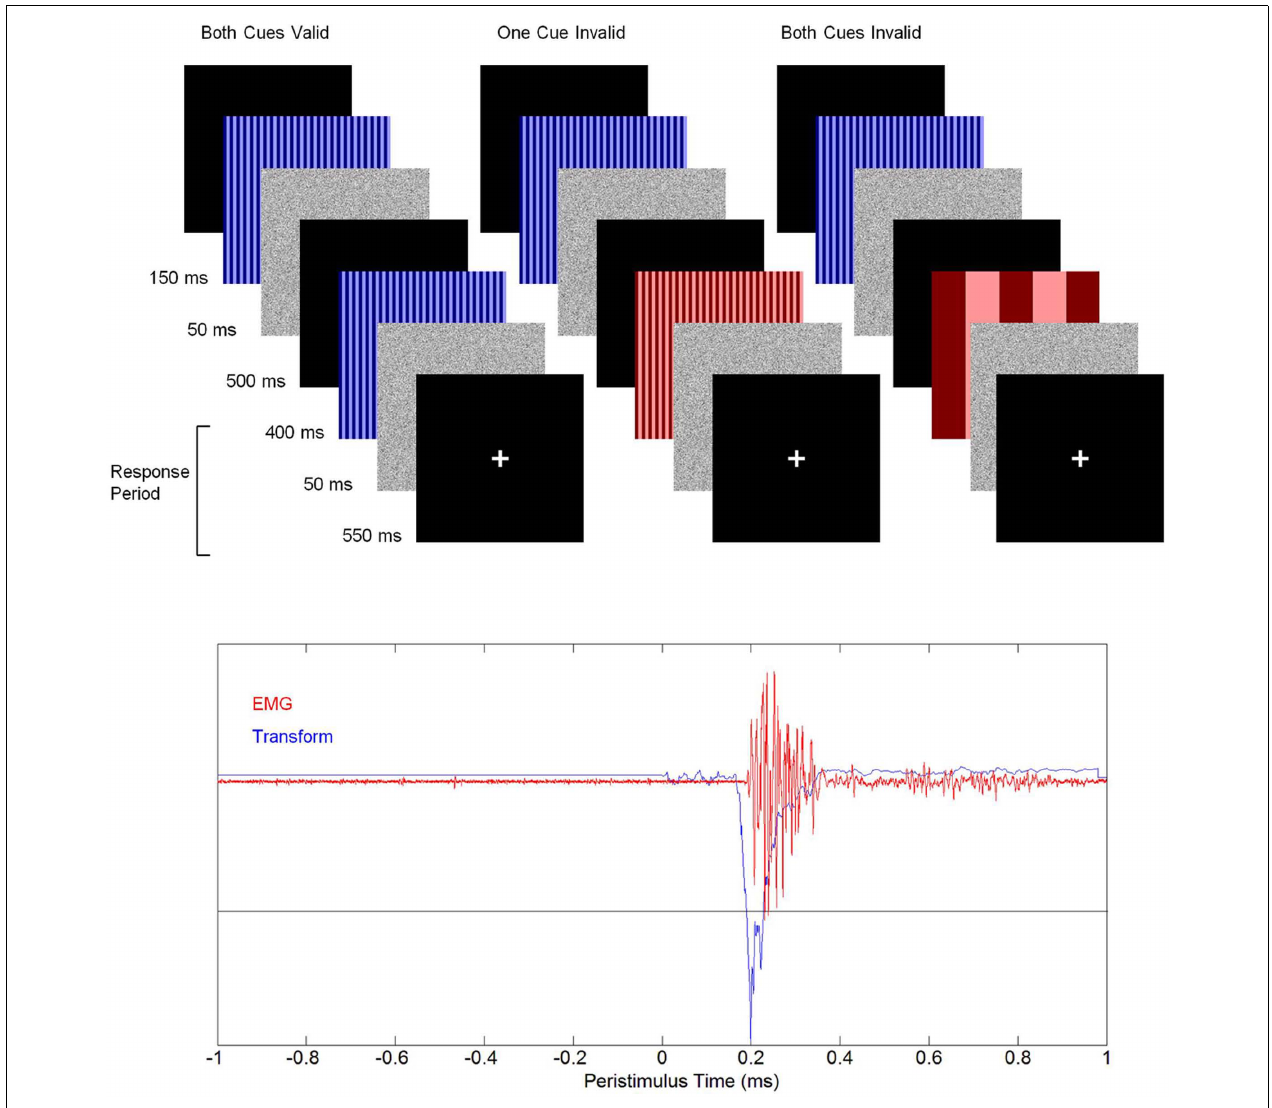
right hand). Bottom panel: Example EMG trace acquired from a single muscle, plotted with the transform used for identifying movement onset. The line shows the ad hoc threshold used to derive reaction times